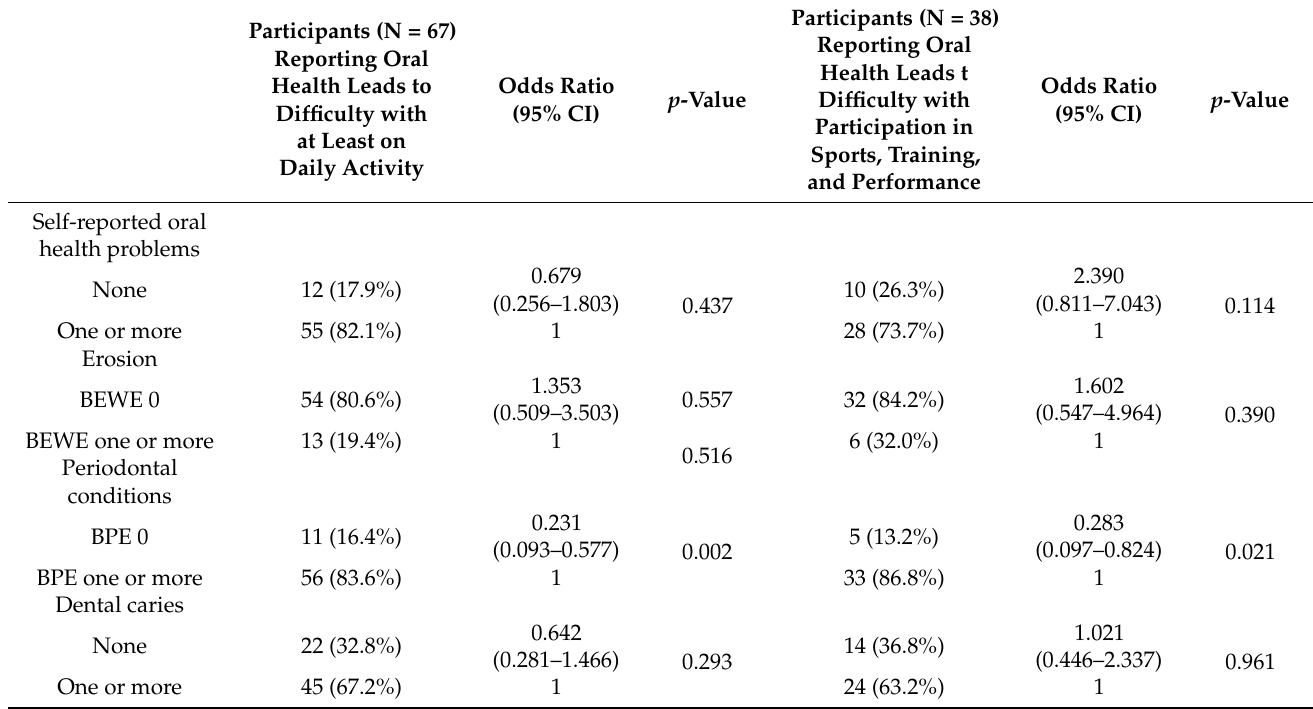
Table 5. Crude odds ratio for the association of self-reported oral health, clinical oral health indicators and impact of oral health daily activities on participation in